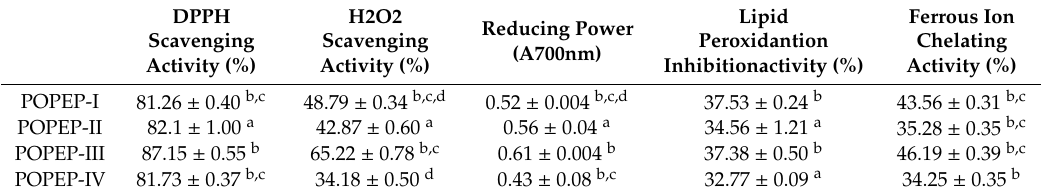
Table 4. Comparison of in vitro antioxidant e ff ects of di ff erent POPEP fractions. The values are presented as the mean ± SD (n = 3). The same letters after the mean indicate statistically insignificant di ff erences between the groups ( p <